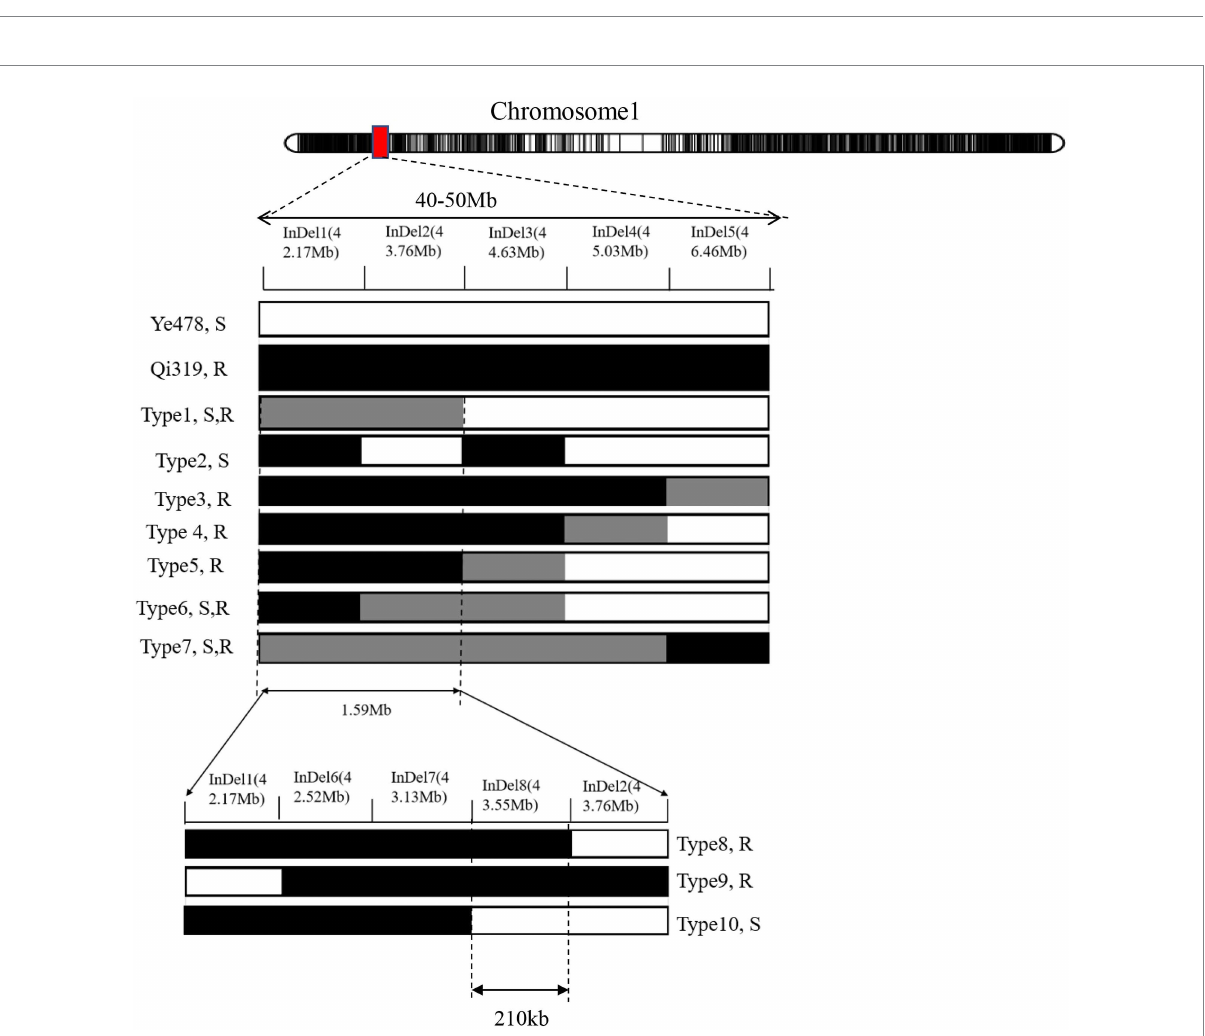
FIGURE 2 (A) Narrowing of the qFER1.03 interval using an F 2 hybrid generation derived from a cross between CL171 and Ye478. Black and gray rectangles represent homozygous Qi319 alleles and homozygous Ye478 alleles, respectively. Light gray indicates heterozygous alleles of Qi319 and Ye478. S and R refer to susceptible and resistant, respectively. (B) Narrowing of the qFER1.03 interval using an F 3 inbred generation derived from the selfing of Type